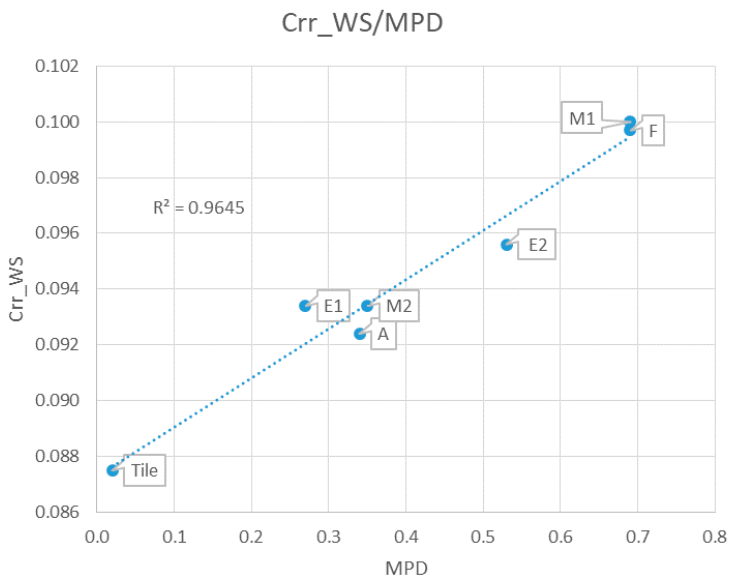
Figure 7. Comparison between Crr_WS and MPDs.